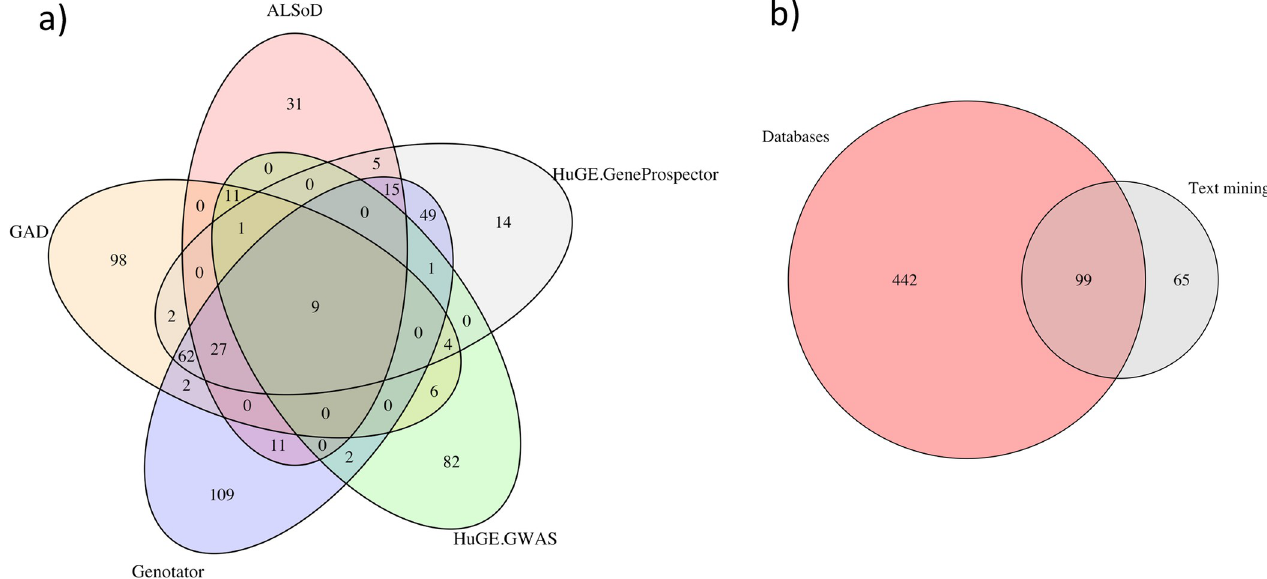
Fig 2. Overlap between ALS resources. Overlap between proteins suggested to be ALS-associated. Panel A: Overlap between the 5 largest ALS databases. Panel B: Overlap between the combined databases and the text mining-based list.